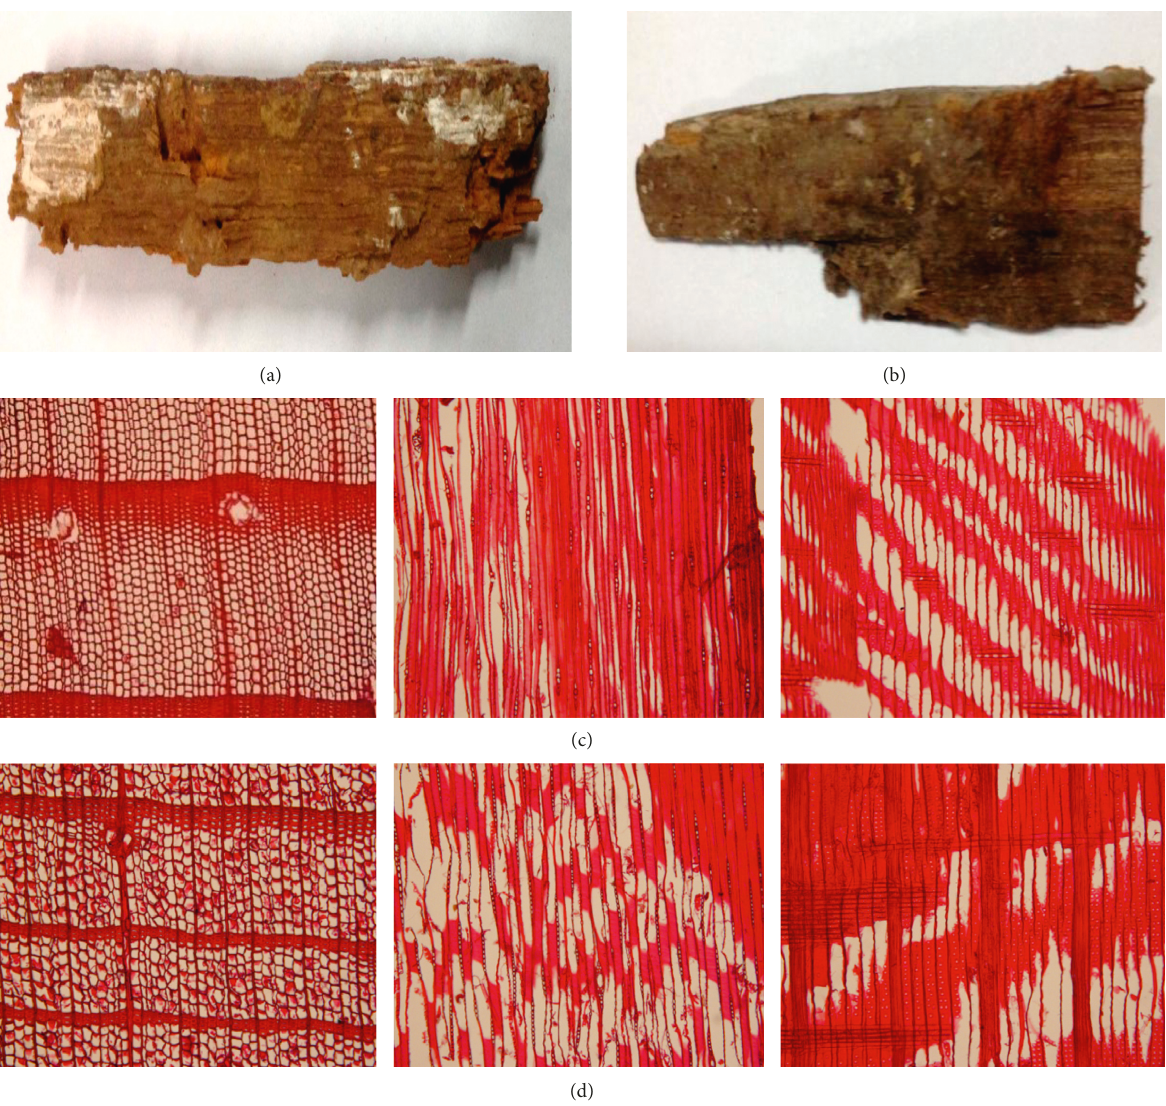
Figure 4: Analysis of wooden component samples for tree species analysis: (a) pillar B2, (b) beam between B3 and B4, (c) and (d) microscopic images of three types of section of the Larix tree